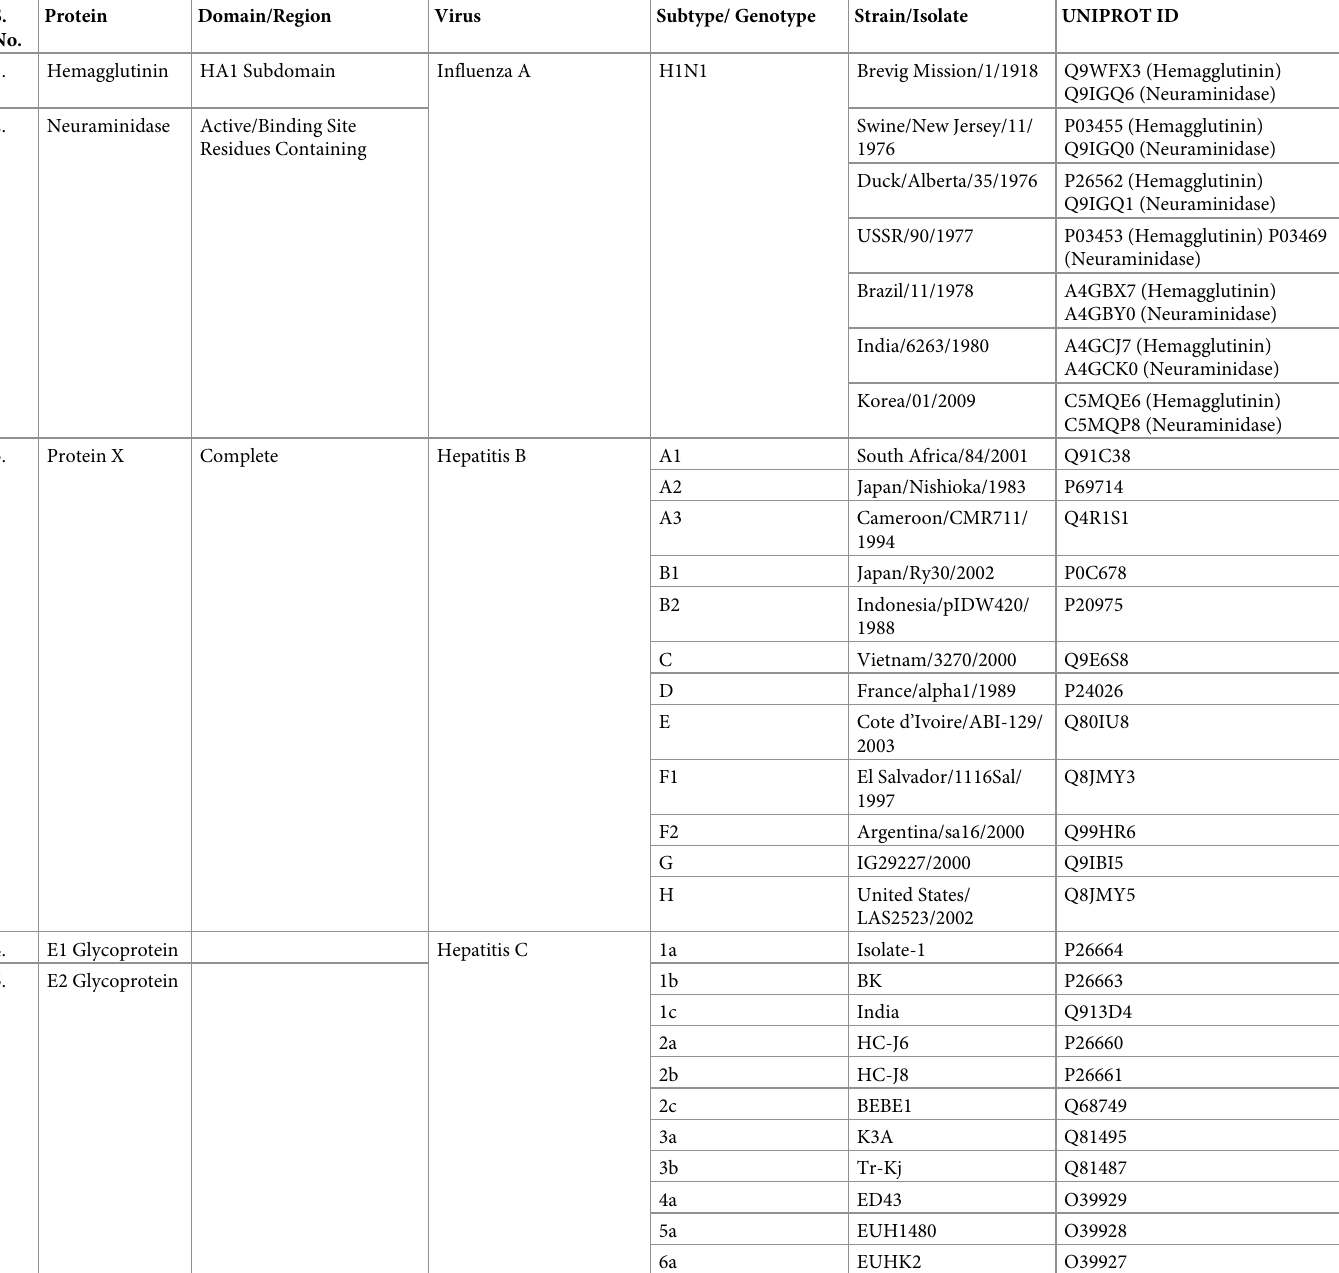
Table 2. Viral Protein selected for phylogenetic analysis along with the details of virus subtype/genotype and strain/isolate. S. No.